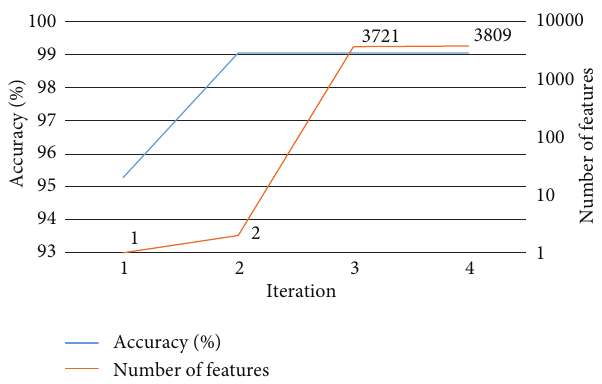
Figure1:Selectionresultsofthesequentialforwardfeatureselection